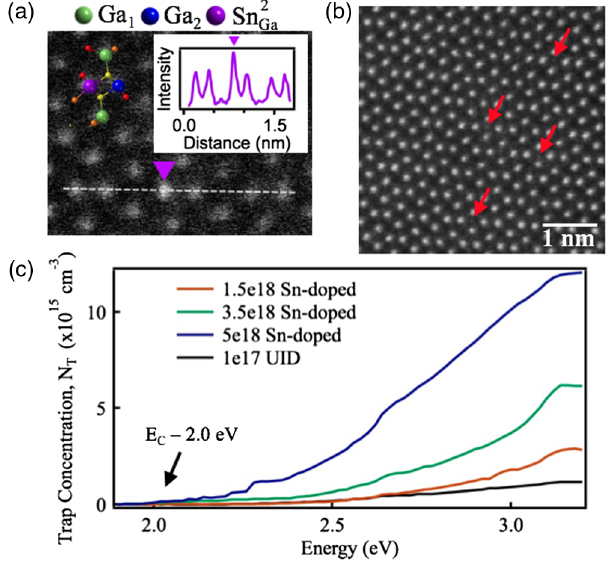
FIG. 4. STEM and DLOS results for point defects and defect complexes in β -Ga 2 O 3 . (a) HAADF STEM image of an atomic column containing Sn dopants (purple triangle) in ½ 010 (cid:2) m bulk Sn-doped β -Ga 2 O 3 . The inset shows the line profile along the dashed line in the figure. (b) HAADF STEM image of UID β -Ga 2 O 3 showing interstitial defects, with red arrows indicating detected Ga interstitials in the i c sites. (c) DLOS as a function of Sn doping in bulk β -Ga 2 O 3 . The trap detected at E C − 2 . 0 eV shows a positive correlation with Sn